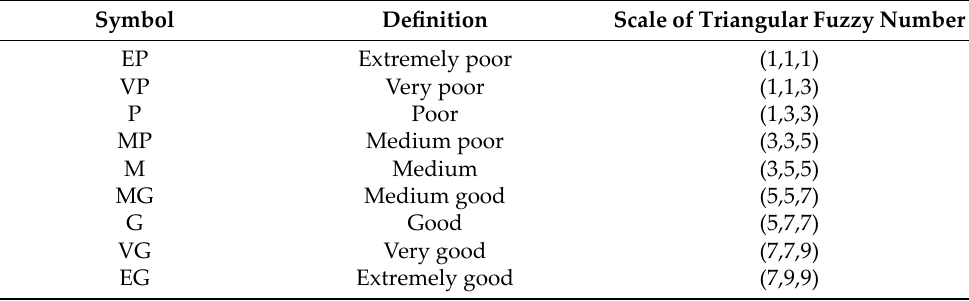
Table 3. Linguistic scale for evaluating potential alternatives